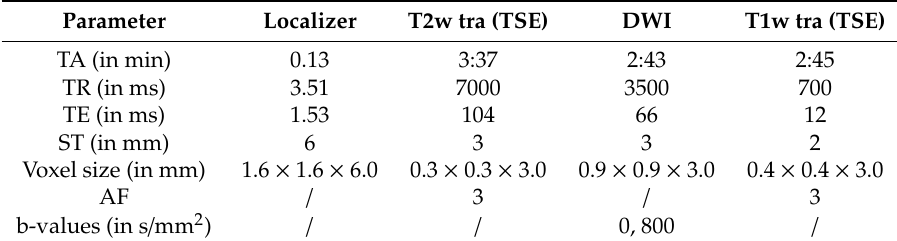
Table 1. Biparametric examination protocol of the